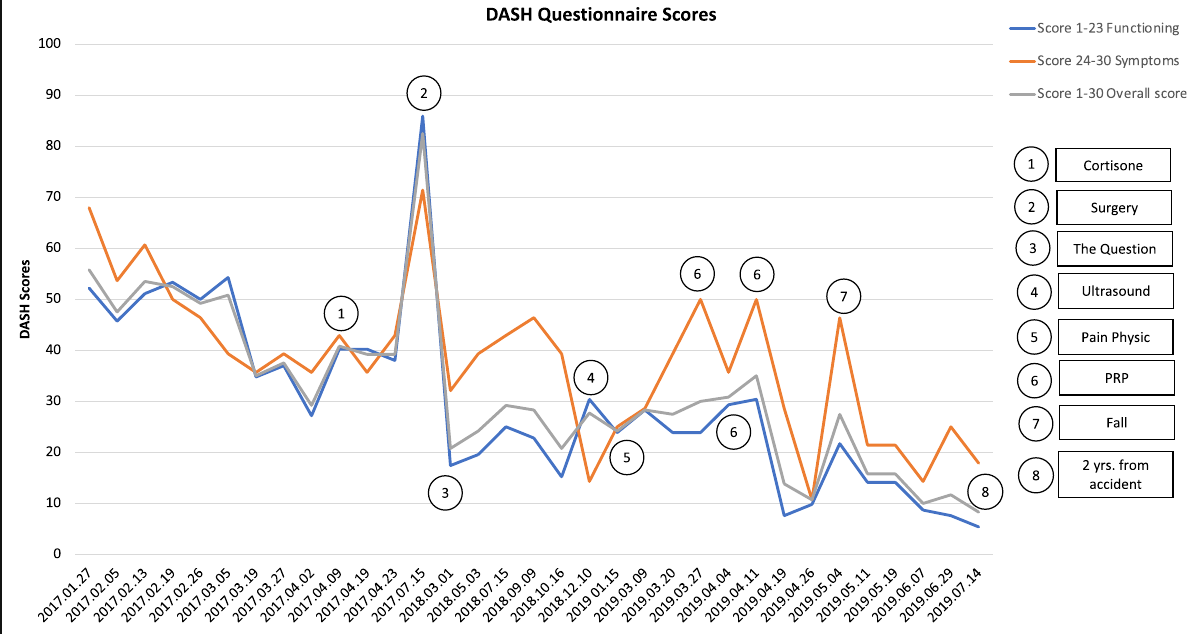
Fig. 1 Disability of Arm, Shoulder and Hand (DASH) scores 3 months to 2 years after the